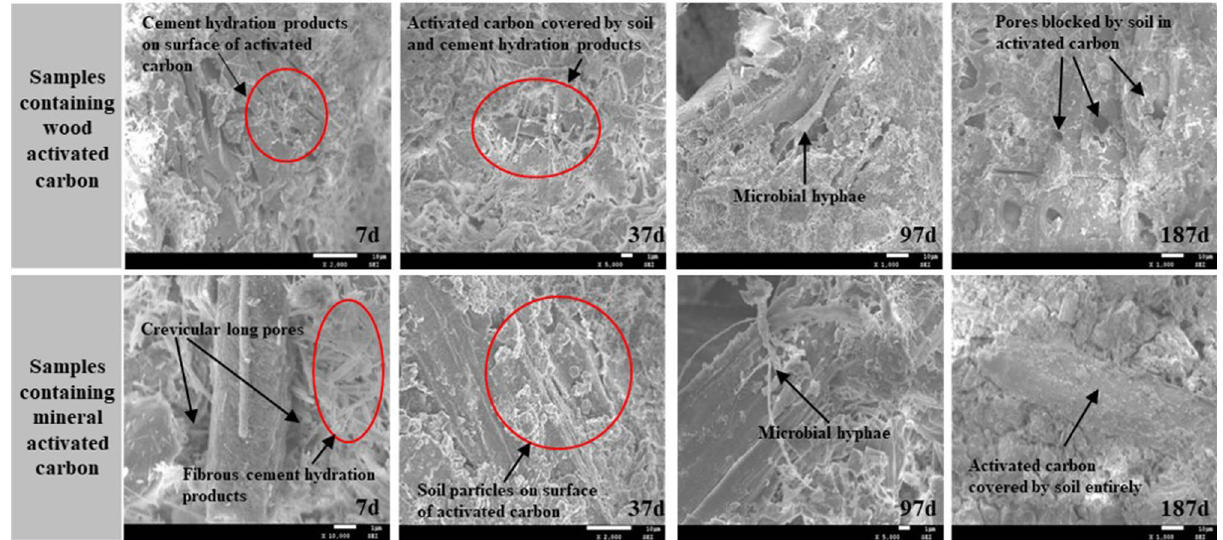
Figure 10. SEM images of samples taken at different